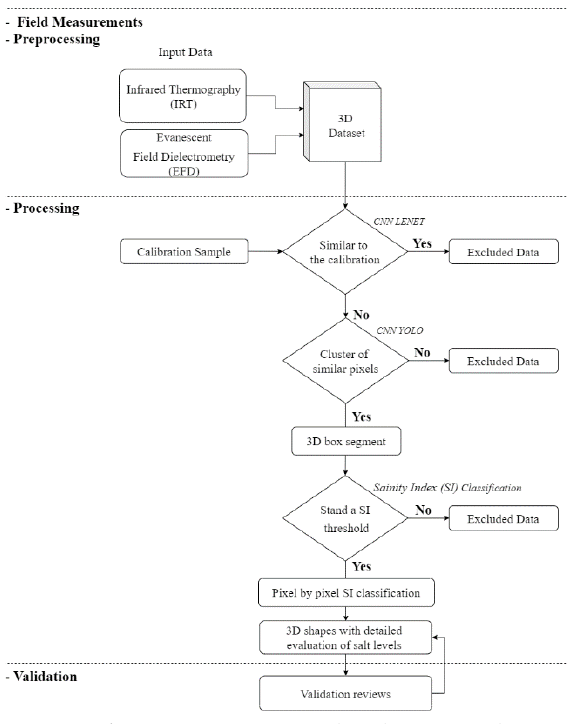
Figure 8. Setup diagram of the four stages of the deep learning–based mapping